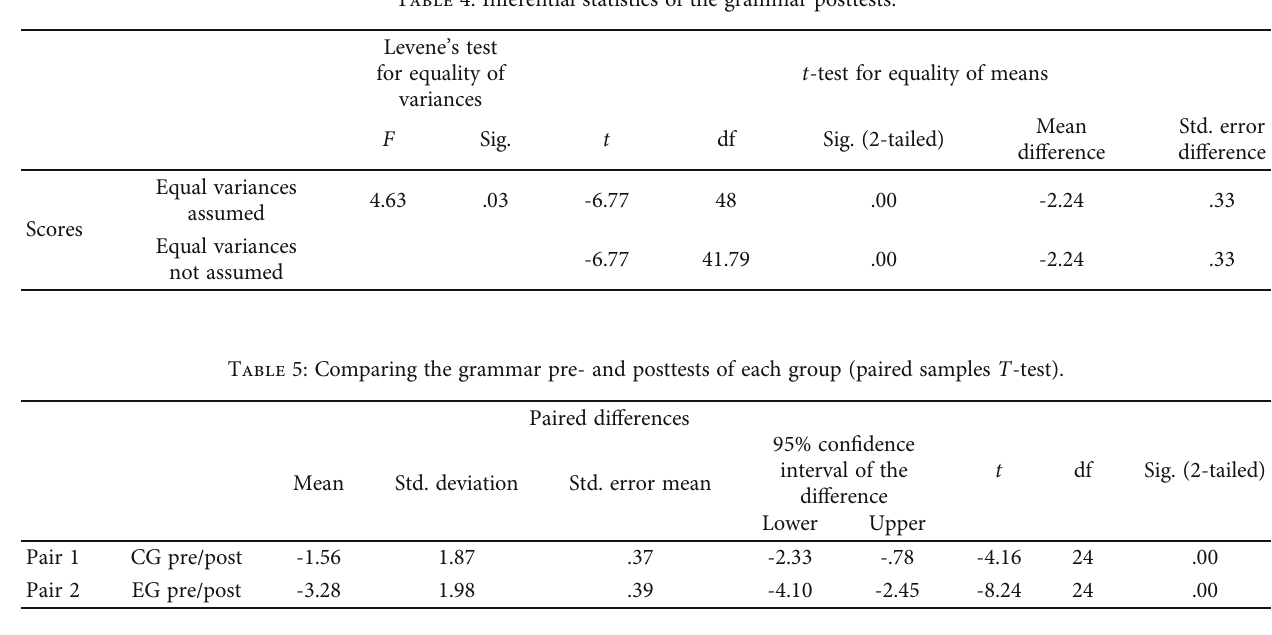
Table 4: Inferential statistics of the grammar posttests.